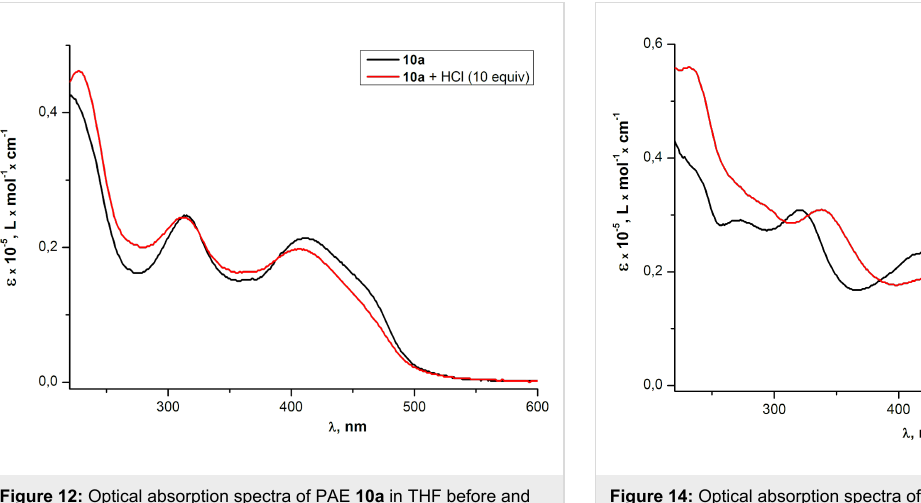
Figure 14: Optical absorption spectra of PAE 10b in THF before after the addition of methanol solution of PdCl 2 .